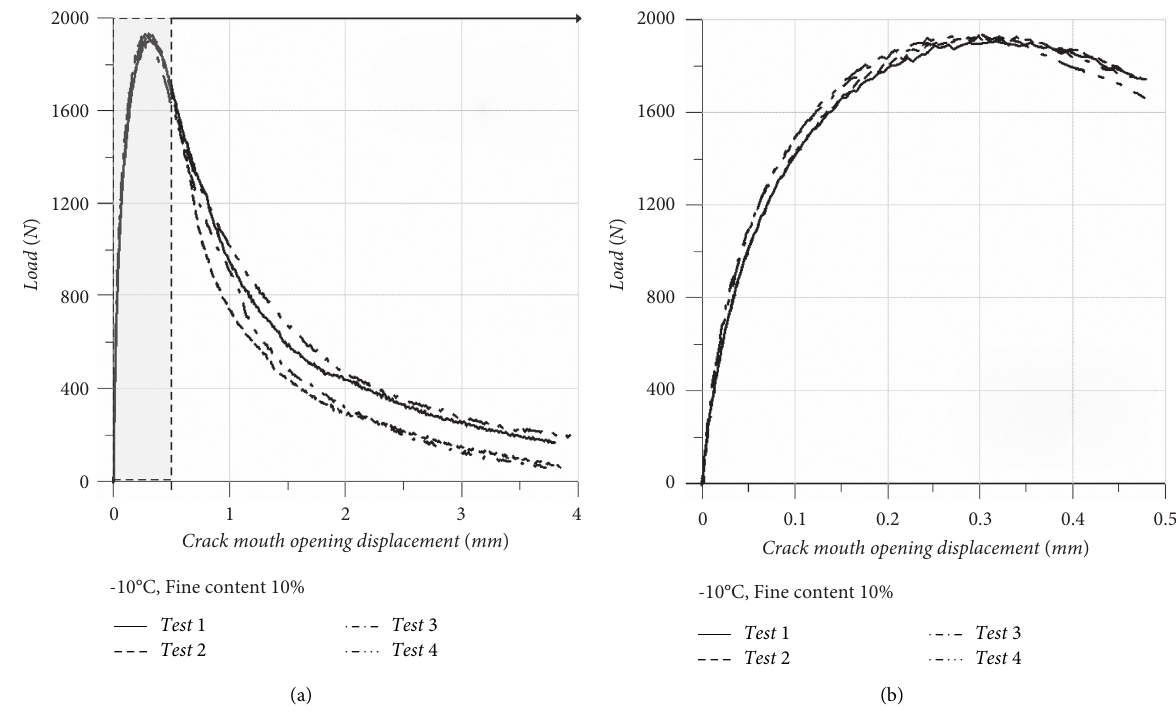
Figure 10: Load-CMOD curves of frozen sand with 10% fine contents at − 10 ° C. (a) Whole test results. (b) Test results up to 0.5mm